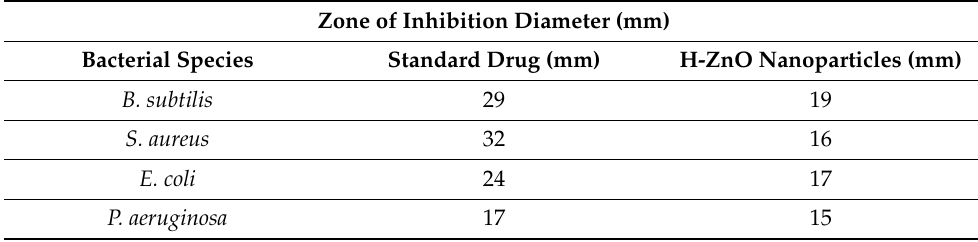
Figure 6. Antibacterial activity of ZnO and H-ZnO nanoparticles compared to the standard antibiotic amikacin. Table 1. Effect of H-ZnO nanoparticles on antibacterial activity.